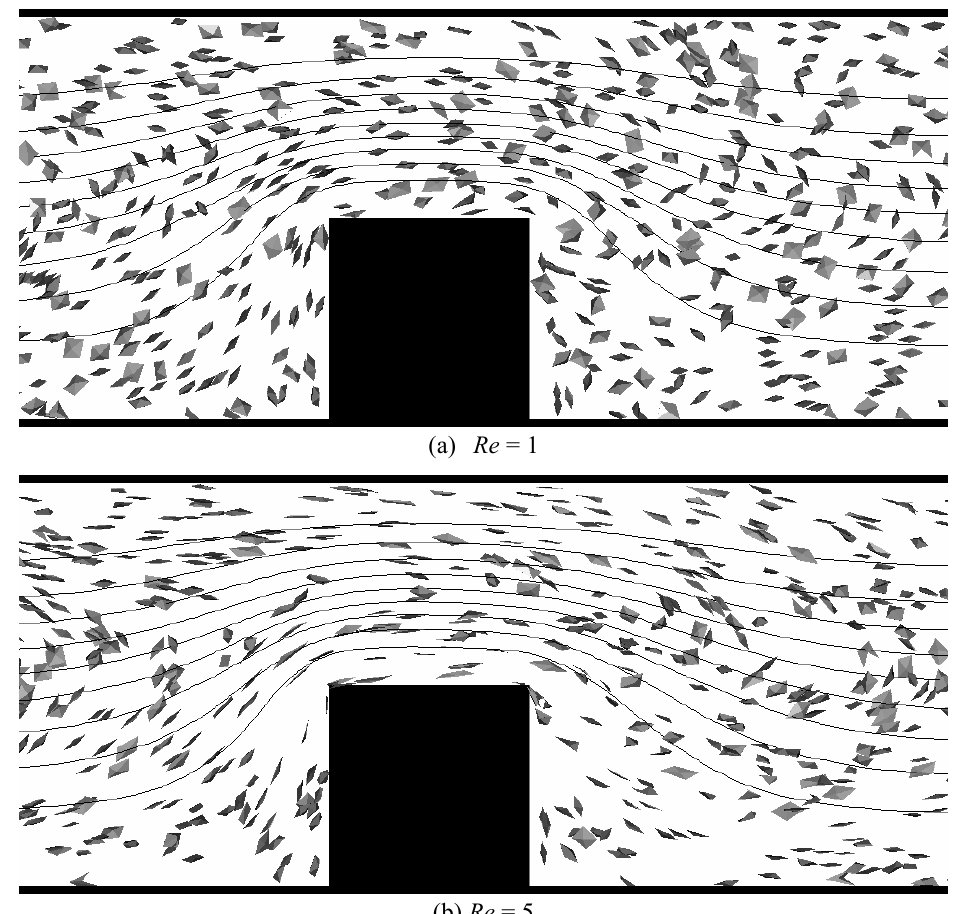
Fig.4 Effect of Re on the flow fields and the deformation of erythrocyte